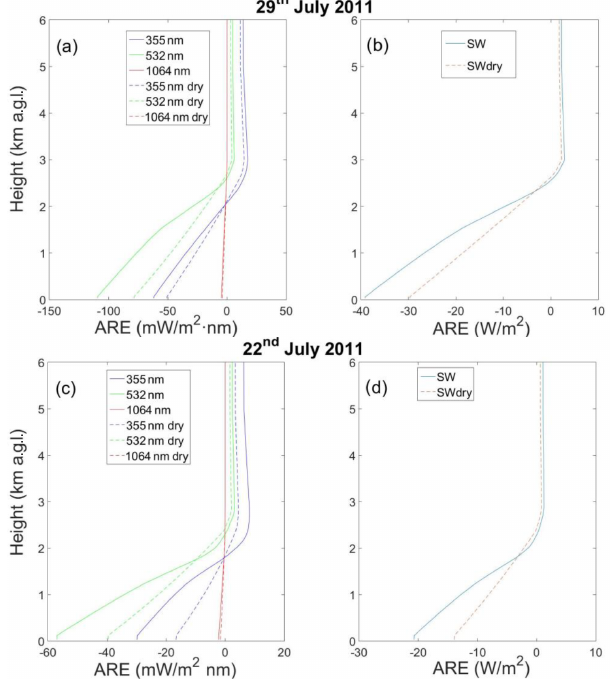
Figure 17. Vertical profiles of aerosol ARE from the lidar measure- ments affected by aerosol hygroscopic growth. Data are presented (a, c) for the measured lidar measurements (355, 532 and 1064nm) and (b, d) integrated for the shortwave range